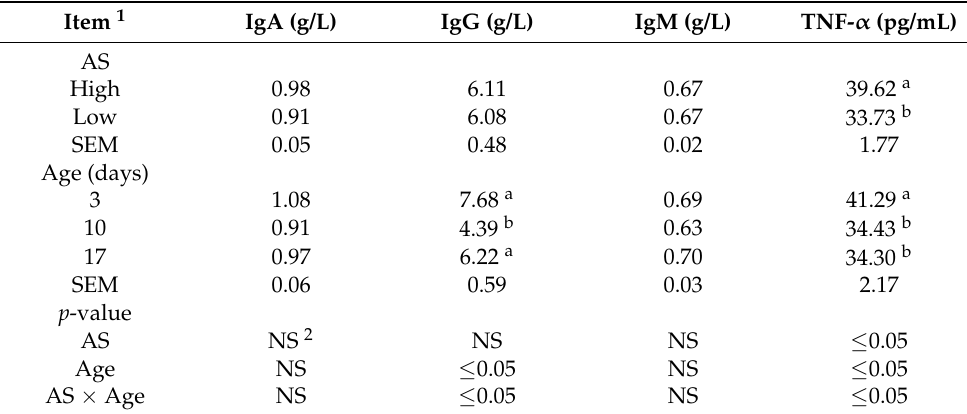
Table 7. Immunity parameters of calves in D3-HA and